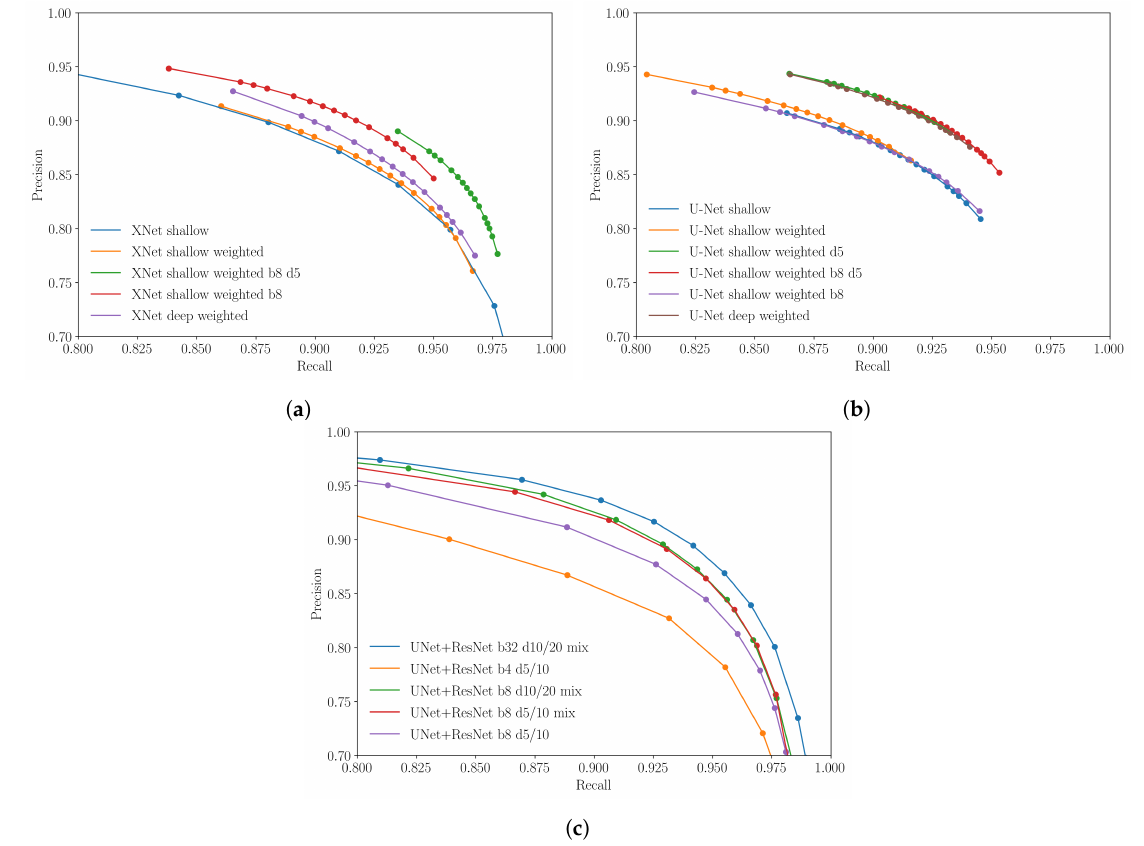
Figure 8. Precision-recall curves for different experiments: ( a ) XNet trials; ( b ) U-Net trials; ( c ) U-Net+ResNet trials. The curves show the precision and recall values at different probability thresholds ranging from 0.01 to